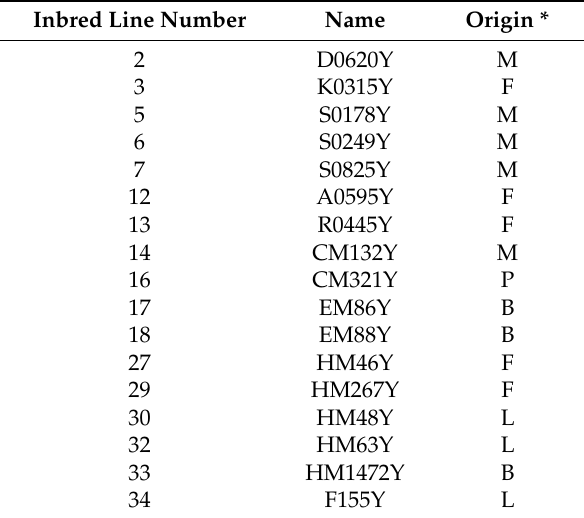
Table 1. Name and origin of 17 inbred lines used as plant